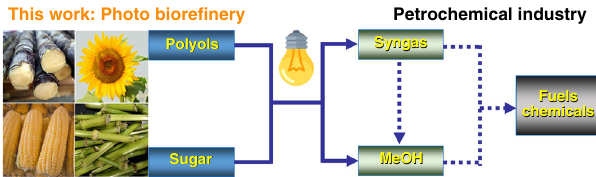
Fig. 1 A concept of bridging biore fi nery and petrochemical industry. Methanol and syngas act as the platform chemical connecting the biore fi nery and petrochemical